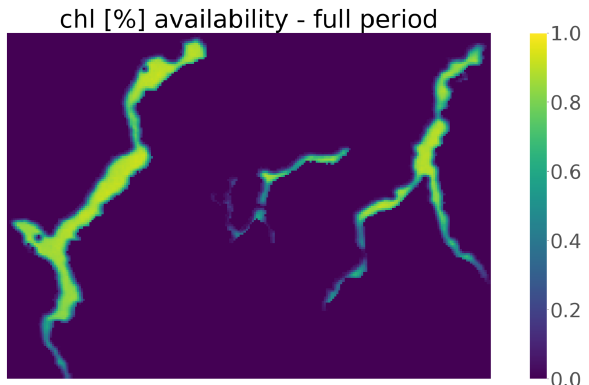
Figure 1. Data availability - Chlorophyll-a, full period.